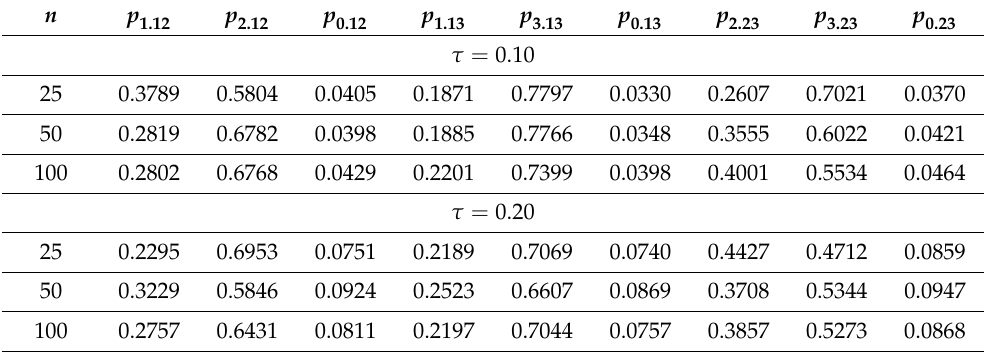
Table 5. Posterior preference probabilities of pairwise competing objects when ties are